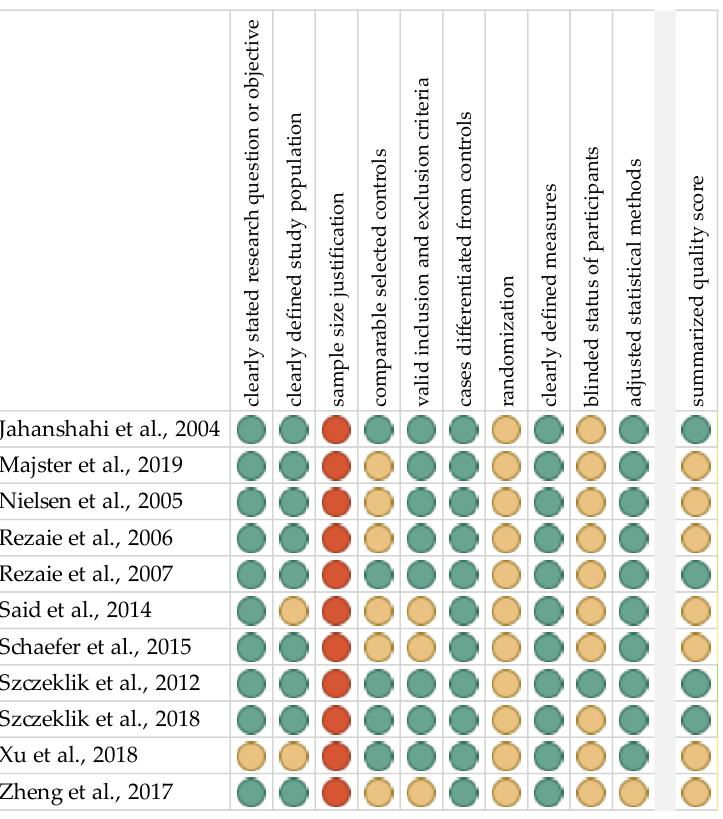
Figure 2. Quality assessment, including the main potential risk of bias (risk level: green – low, yellow – unspecified, red – high; quality score: green – good, yellow – intermediate, red – poor).